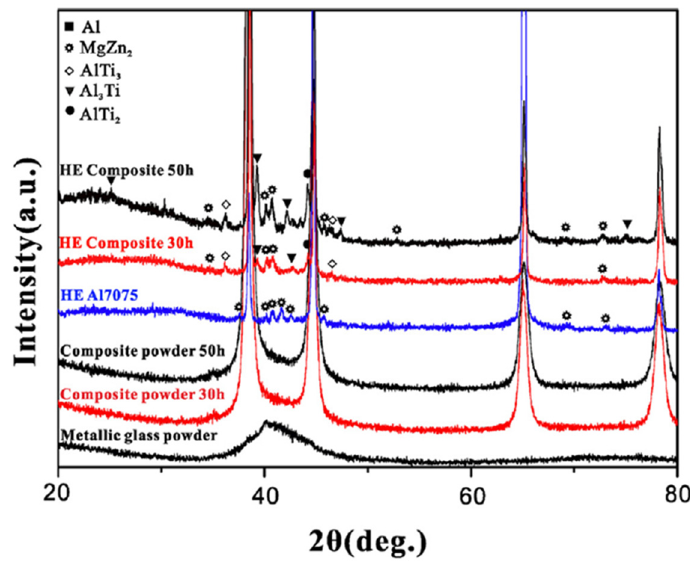
Figure 16. XRD patterns of the Ti 52 Cu 20 Ni 17 Al 11 metallic glass , Al 7075 + 8 vol.% Ti 52 Cu 20 Ni 17 Al 11 mixtures, hot-extruded matrix alloy, and composites obtained from the Al 7075 + 8 vol.% Ti 52 Cu 20 Ni 17 Al 11 mixtures milled for 30 h and 50 h. Reprinted from [67], Copyright (2018), with permission from Elsevier.